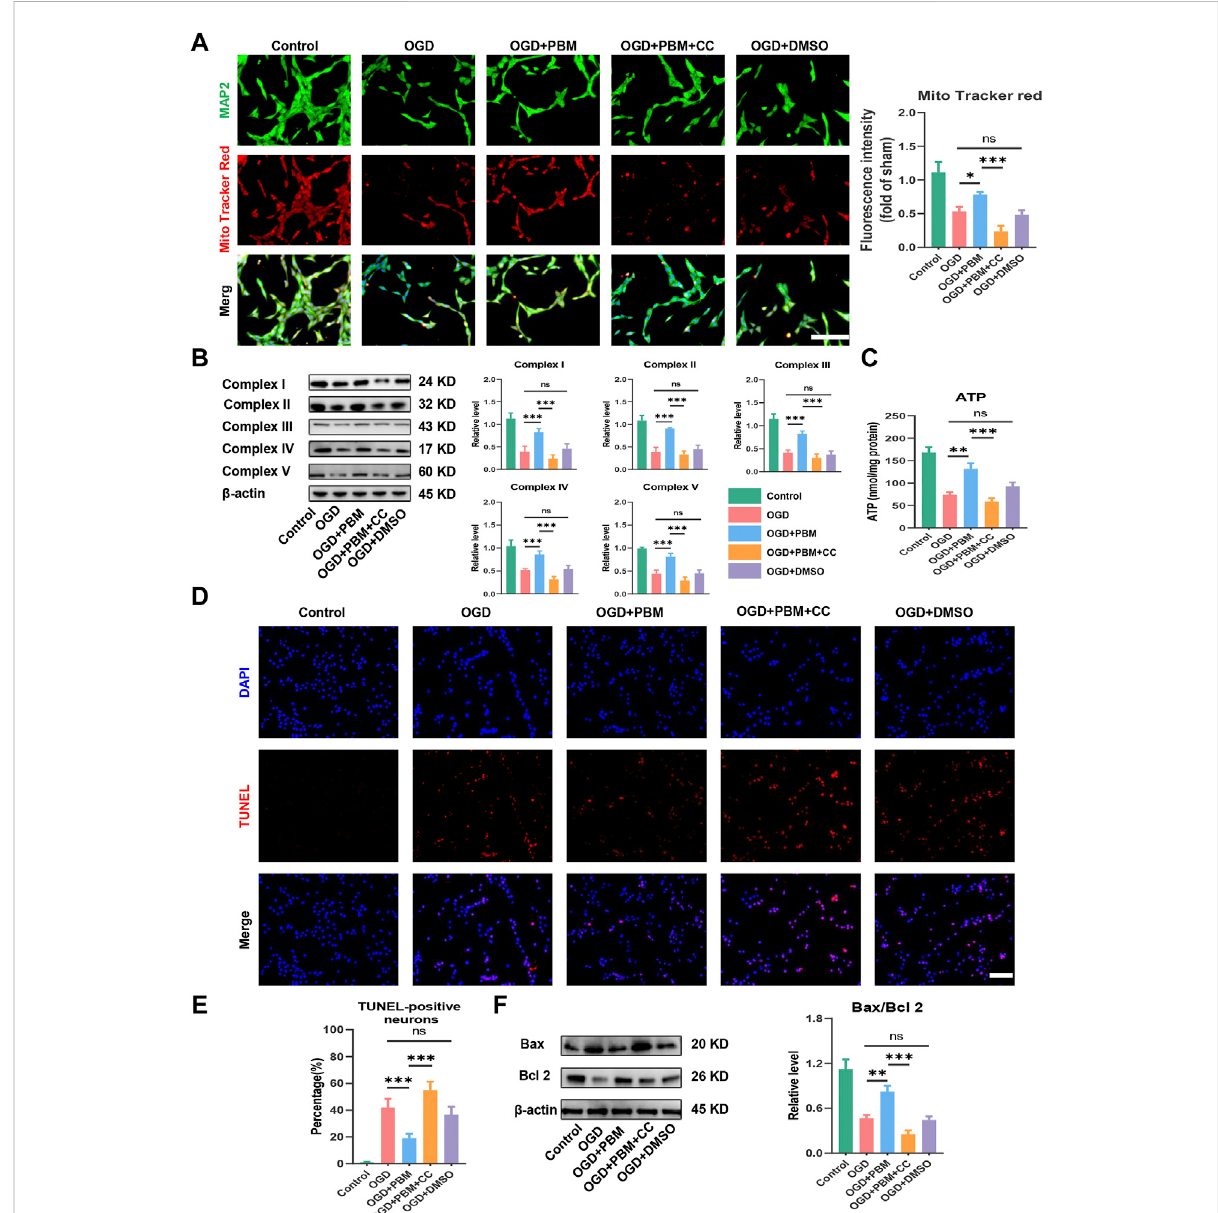
FIGURE 6 Inhabitation of AMPK/PGC-1 α /TFAM pathway reversed theeffects of PBM in vitro . (A) :Representative images of VSC 4.1(MAP2,green) and Mito Tracker (red) for each group. Nuclei were stained with DAPI (blue). Quanti fi cation of the intensity of Mito Tracker red relative to that in the control group,Scalebar:50 µm n =3. (B) :Westernblotanalysisandquanti fi cationoftheexpressionlevelsofComplexI – Vineachgroup, n =4. (C) :Resultof ATPproductionineachgroup, n =4. (D,E) :TUNEL(red)andDAPI(blue)co-stained,Scalebar:50 µm.The ratioofTUNLE-positiveneuronswas calculated, n = 4. (F) : Western blot analysis and quanti fi cation of Bax, Bcl2 expression levels in each group, n =